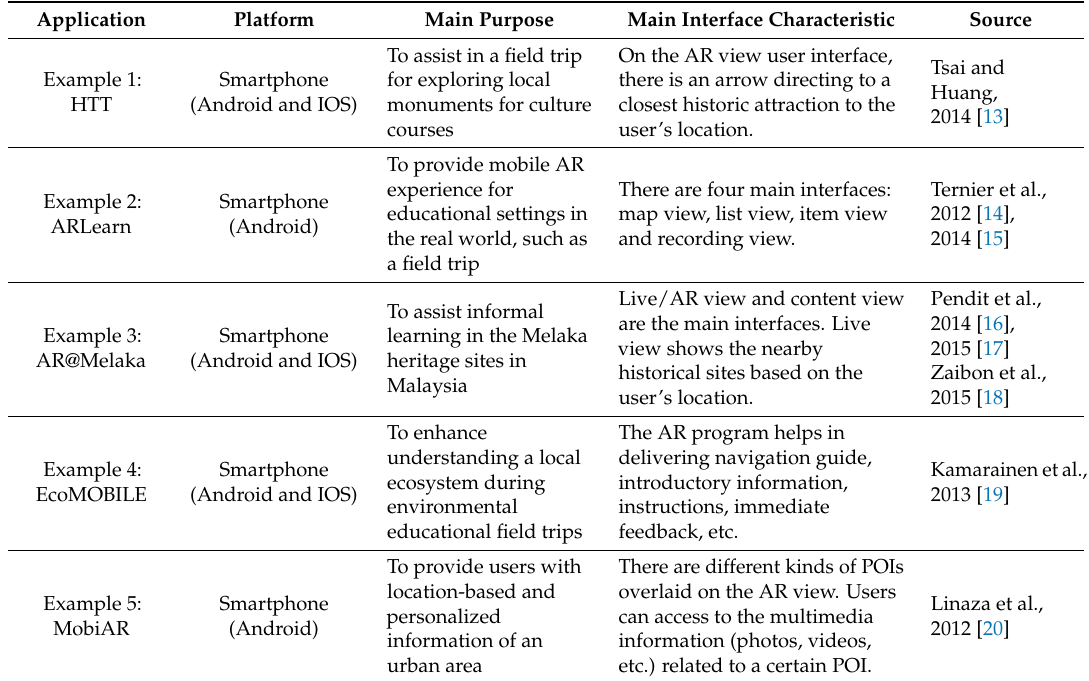
Table 1. Overview of the reviewed mobile AR